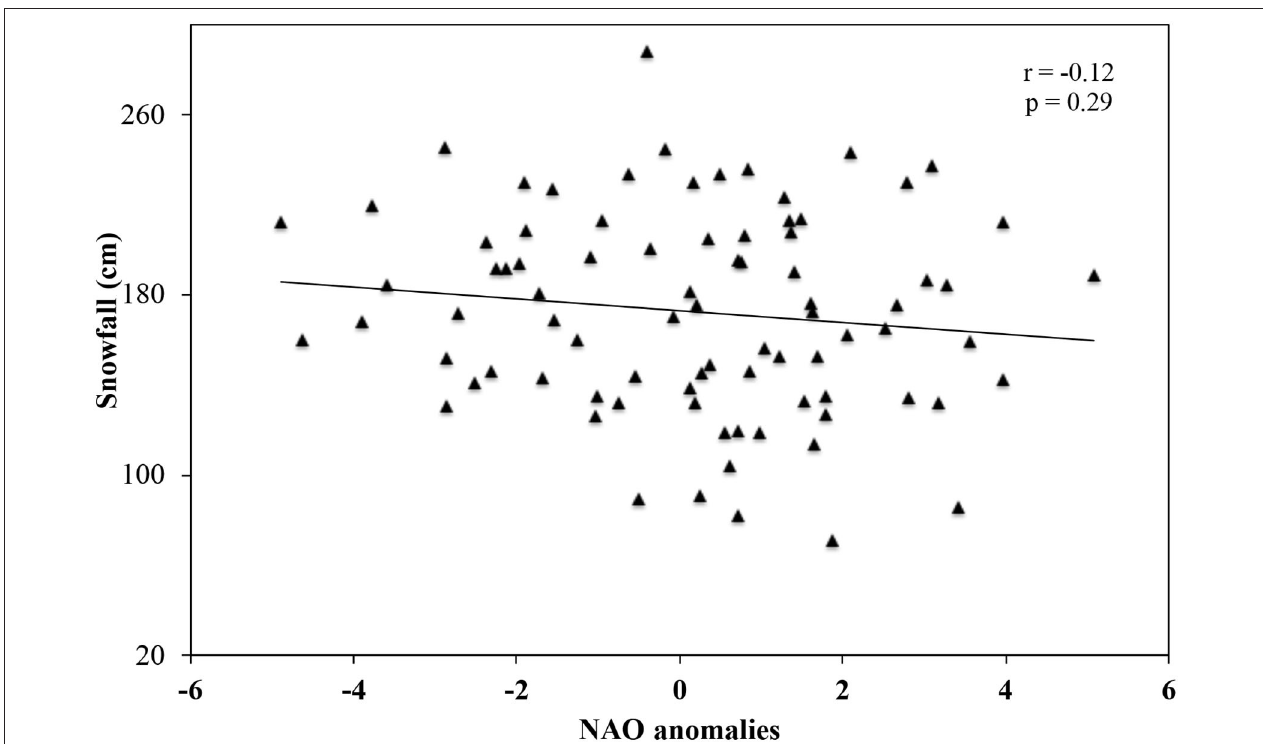
FIGURE 7 | Scatter plot of average annual total snowfall over the eight stations vs. the NAO index. A Pearson correlation coefficient ( r ) and p -value are shown on this